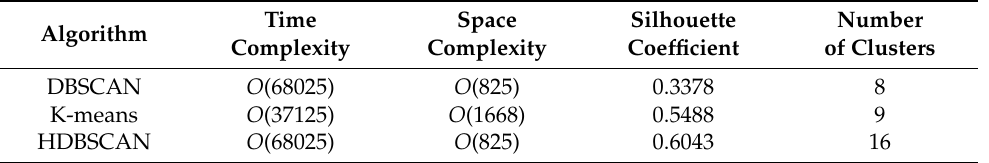
Table 3. Comparison of clustering results of DBSCAN, K-means and HDBSCAN.